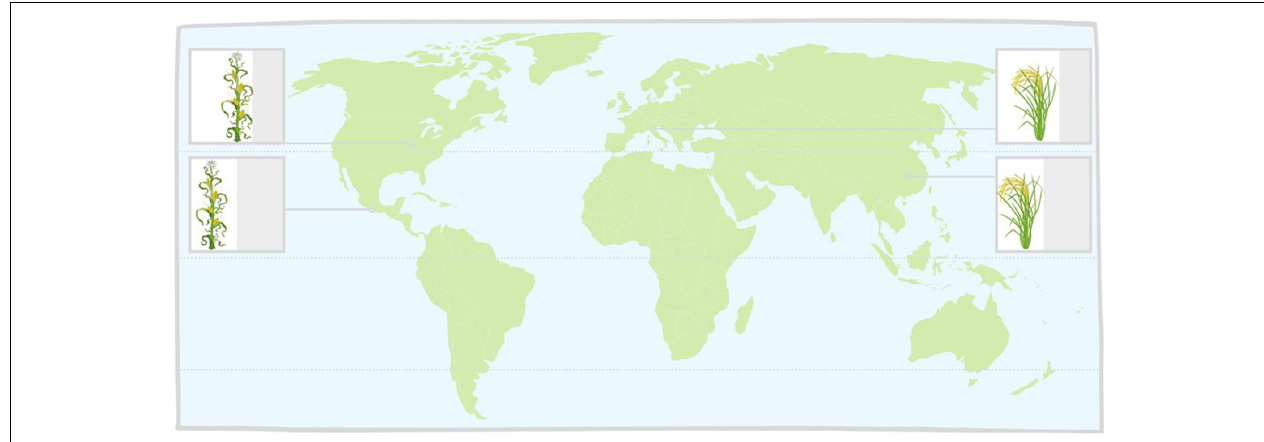
FIGURE 1 | Adaptation of cereal growth to different latitudes. Maps showing the expansion of maize (left) and rice (right) cultivation outside their region of origin. The selection of mutation in genes encoding CCT-type floral repressors that alter photoperiodic response allowed activation of the florigen under non inductive